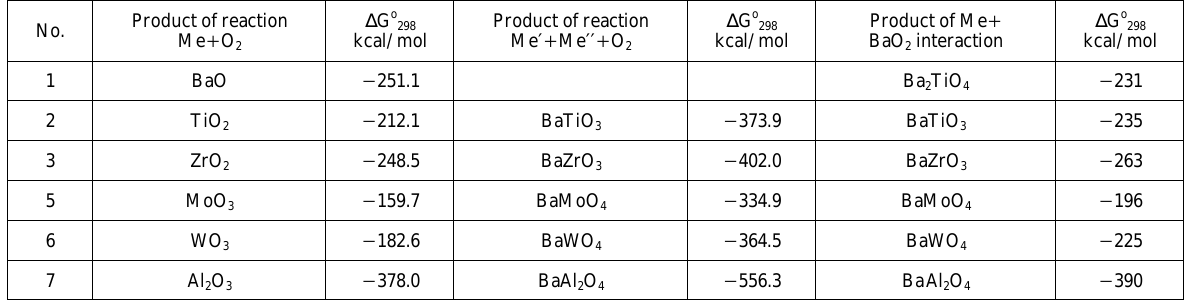
Table 2 Changes of Gibbs’ energy in the oxidation of metals or metal mixtures by oxygen or barium peroxide resulting in the formation of oxides and complex oxides. No. Product of